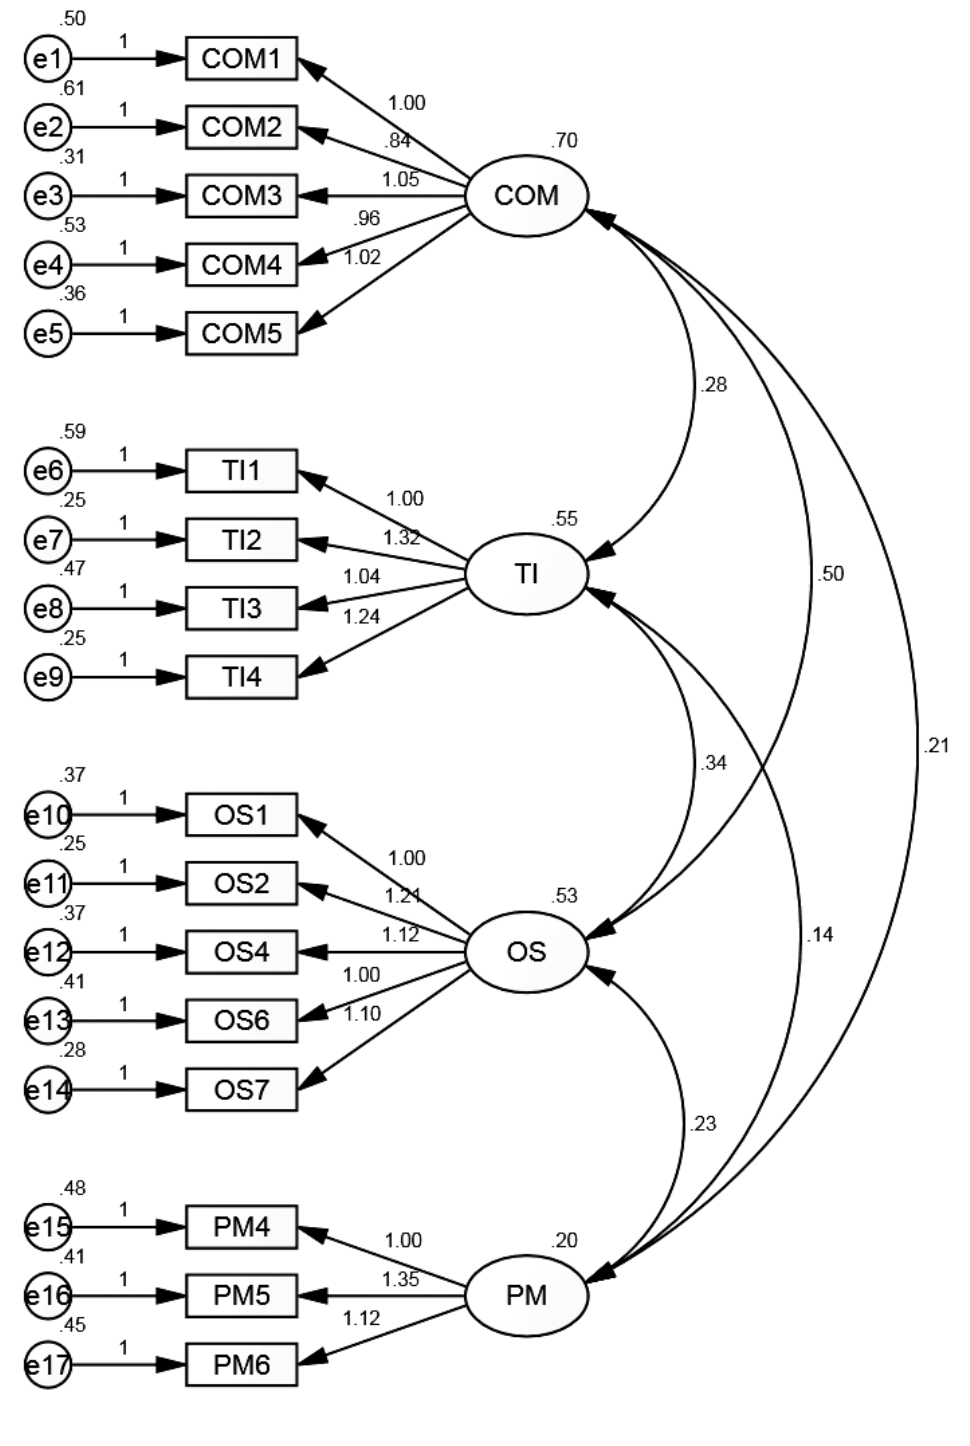
Figure 2. Standardized estimates for the